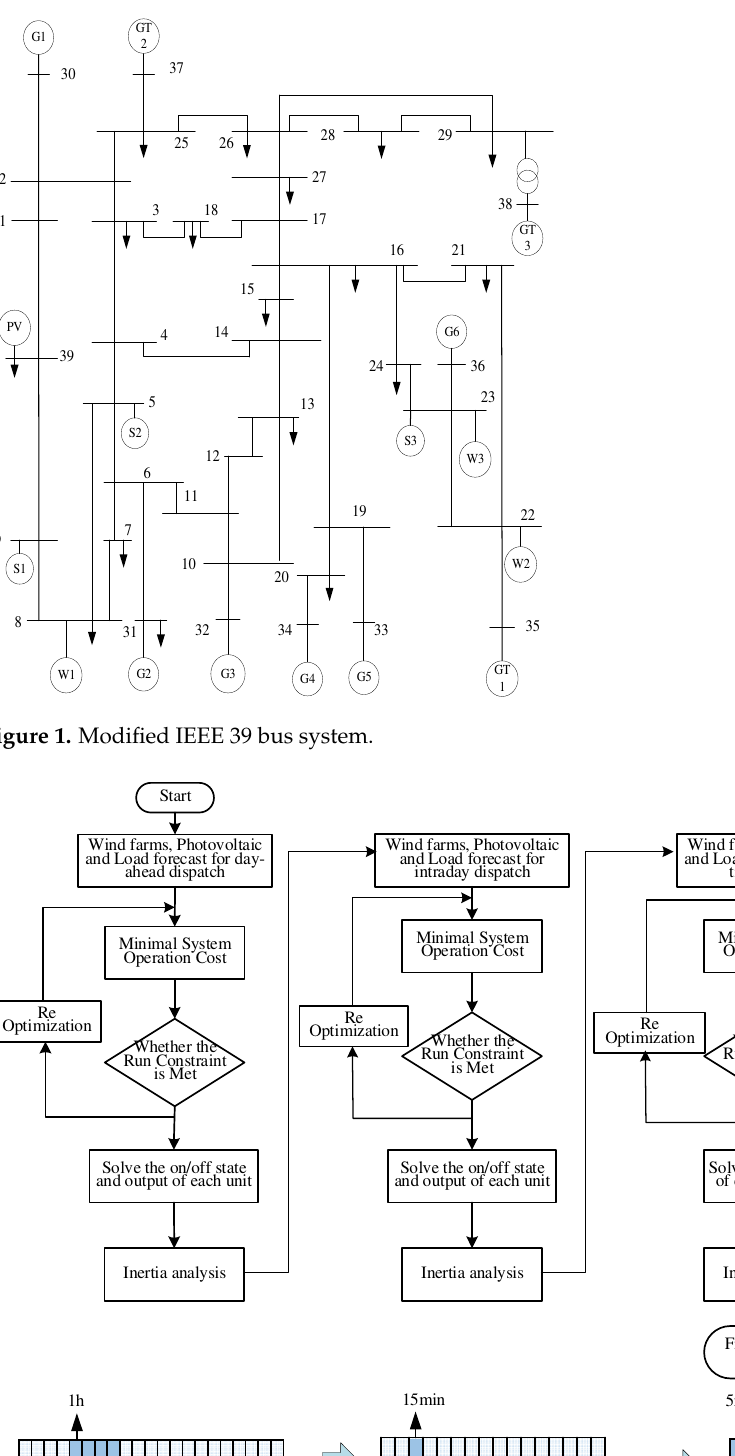
Figure 2. Flow chart of the multi-timescale scheduling strategy.